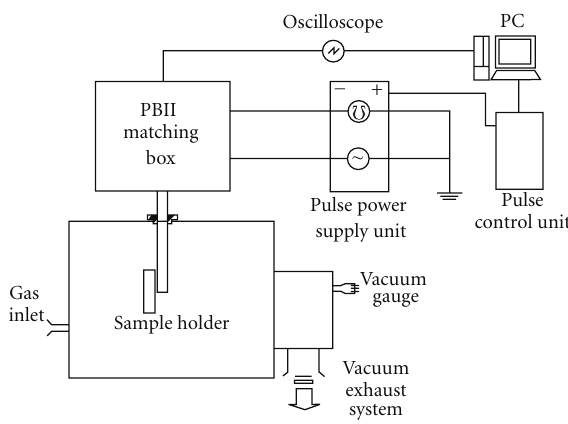
Figure 1: Schematic of the PBII apparatus used in this experiment. Table 1: Surface energy data of liquids used for